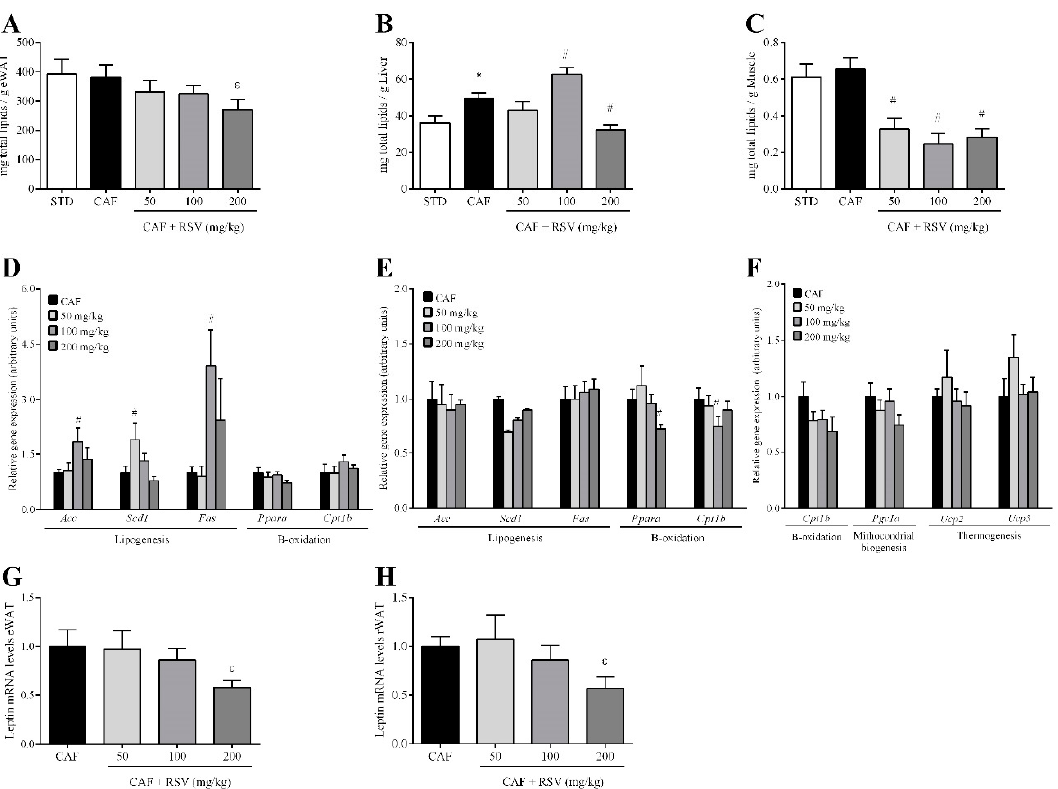
Figure 2. Lipid profile. The rats were fed the STD or CAF diet for 9 weeks. Then, the rats in the STD and CAF groups were treated orally with RSV (50, 100 or 200 mg per kg of body weight) for 3 weeks. Total lipids in ( A ) eWAT, ( B ) liver and ( C ) calf skeletal muscle in mg for each g of tissue. ( D ) Expression in the liver of genes related to lipogenesis ( Acc , Scd1 and Fas ) and β -oxidation ( Ppara and Cpt1b ). ( E ) Expression in eWAT of genes related to lipogenesis ( Acc , Scd1 and Fas ) and β -oxidation ( Ppara and Cpt1b ). ( F ) Expression in calf skeletal muscle of genes related to β -oxidation ( Cpt1b ), mitochondrial biogenesis ( Pgc1a ) and thermogenesis ( Ucp2 and Ucp3 ). Leptin gene expression in ( G ) eWAT and ( H ) rWAT. Data are expressed as the mean ± SEM, n = 6. * denotes p < 0.05, Student’s t -test comparing the CAF group to the STD group. # indicates p < 0.05 and ε p < 0.1, Student’s t -test comparing the RSV group to the CAF group. CAF: cafeteria diet; eWAT: epididymal white adipose tissue; RSV: resveratrol; rWAT: retroperitoneal white adipose tissue; STD: standard chow diet. Acc (acetyl-CoA carboxylase); Cpt1b (carnitine palmitoyltransferase 1b); Fas (fatty acid synthase); Pgc1a (peroxisome proliferator-activated receptor gamma coactivator 1-alpha), Ppara (peroxisome proliferator activated receptor alpha); Scd1 (stearoyl-CoA desaturase 1); Ucp2 (mitochondrial uncoupling protein 2); Ucp3 (mitochondrial uncoupling protein 3).